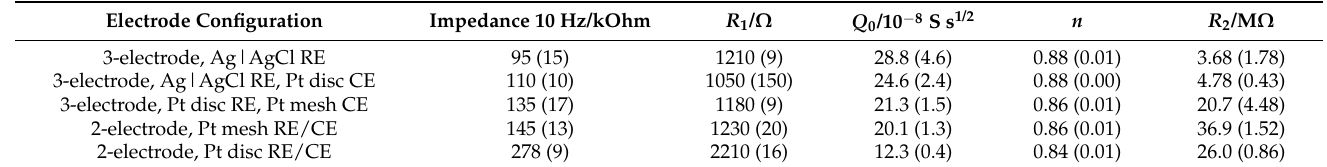
Table 2. Impedance and equivalent circuit fitting parameters of a 0.6 mm diameter platinum electrode in different configurations